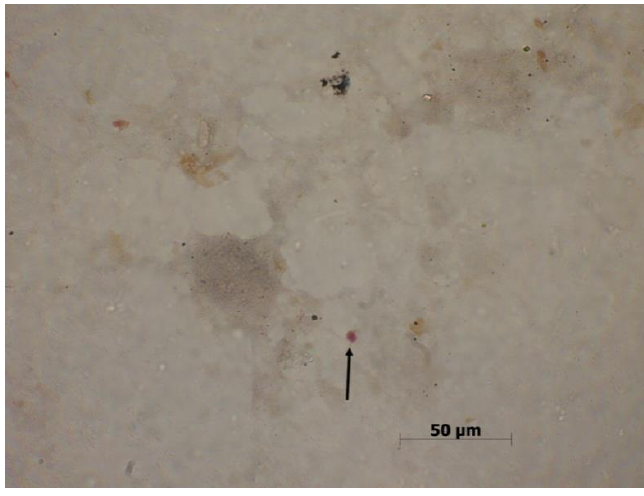
Figure 6. Cryptosporidium sp. at 40x (original photography).